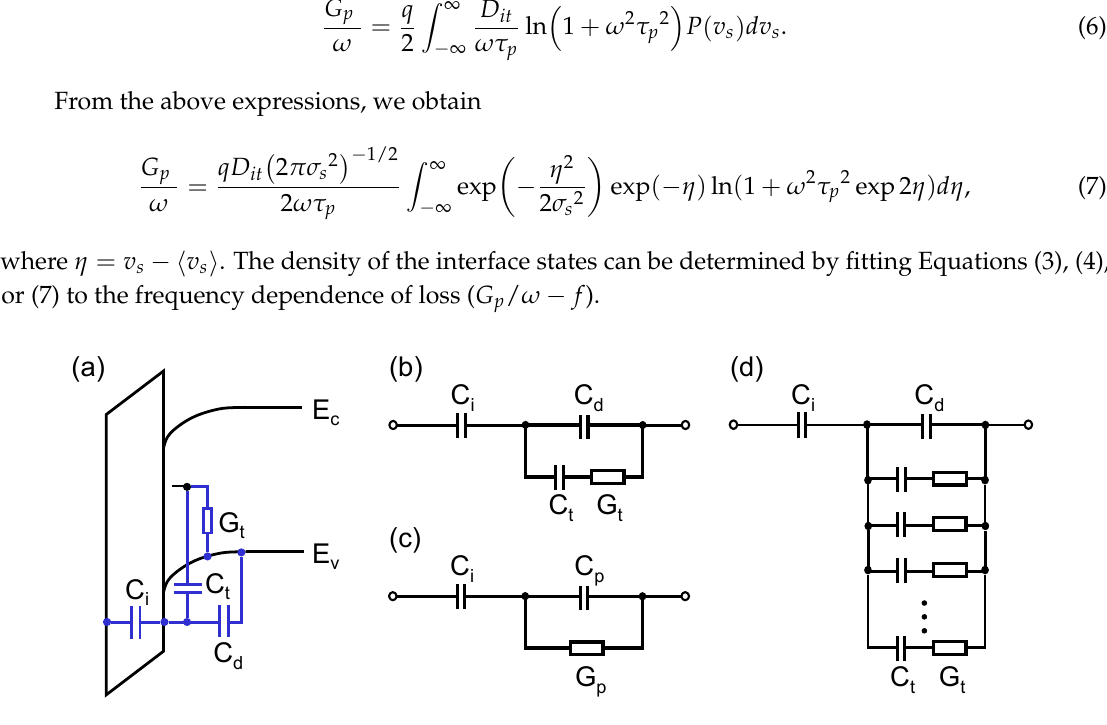
Figure 6. ( a ) Equivalent circuit of a MIS capacitor with single-energy level interface states in depletion mode and ( b ) simplified version of ( a ). ( c ) Lumped parallel equivalent circuit of ( b ) or ( d ). ( d ) Equivalent circuit of a MIS capacitor with energetically distributed interface states.